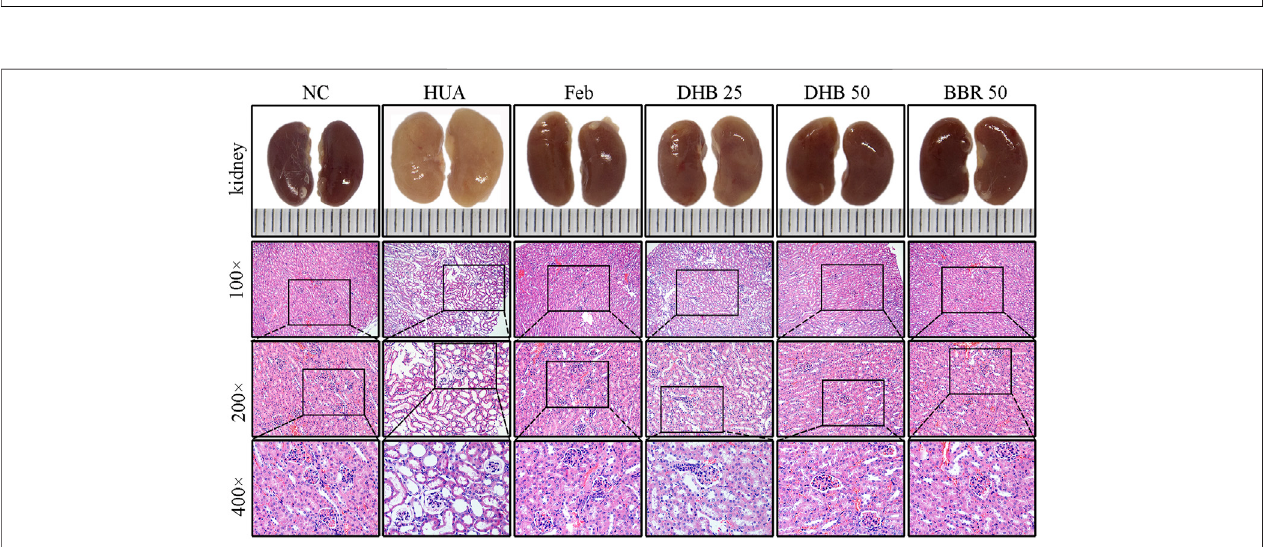
FIGURE 2 | Effect of DHB on serum UA and serum markers of kidney damage in PO/HX-induced hyperuricemic mice. (A) The serum level of UA. (B) The serum level of BUN. (C) The serum level of creatinine. The results are expressed as mean ± SD (n (cid:2) 10). # p < 0.05, ## p < 0.01, compared with NC 616 group; * p < 0.05; ** p < 0.01, compared with HUA group.